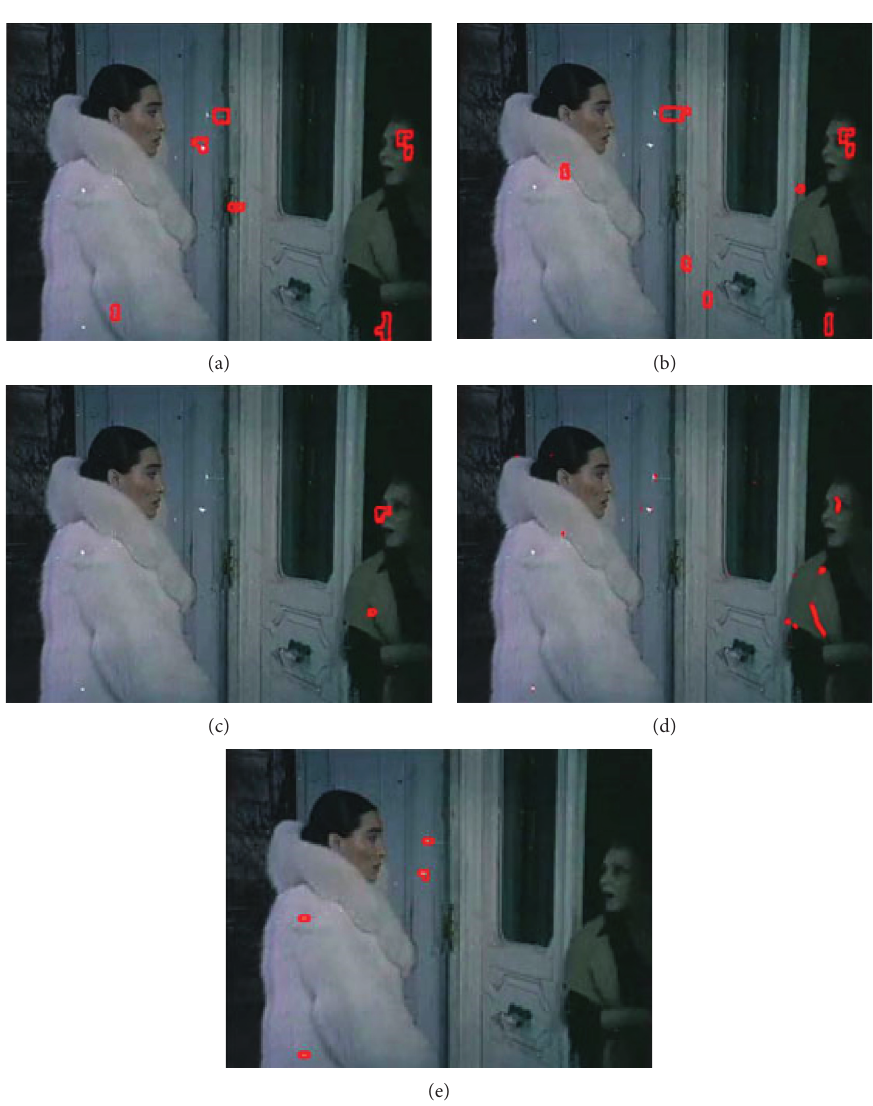
Figure 16: (a) Results of original blotch detection studies for “yesilcam_2” dataset: (a) the HOG feature, (b) the LBP feature, (c) the region- matching, (d) the SDI, and (e) the proposed